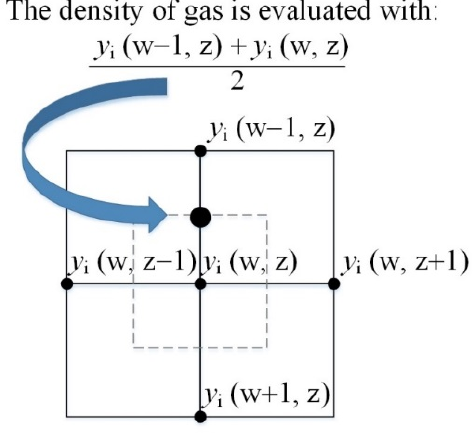
Figure 1. Illustration of the discretization mesh of species/mass conservation equation.